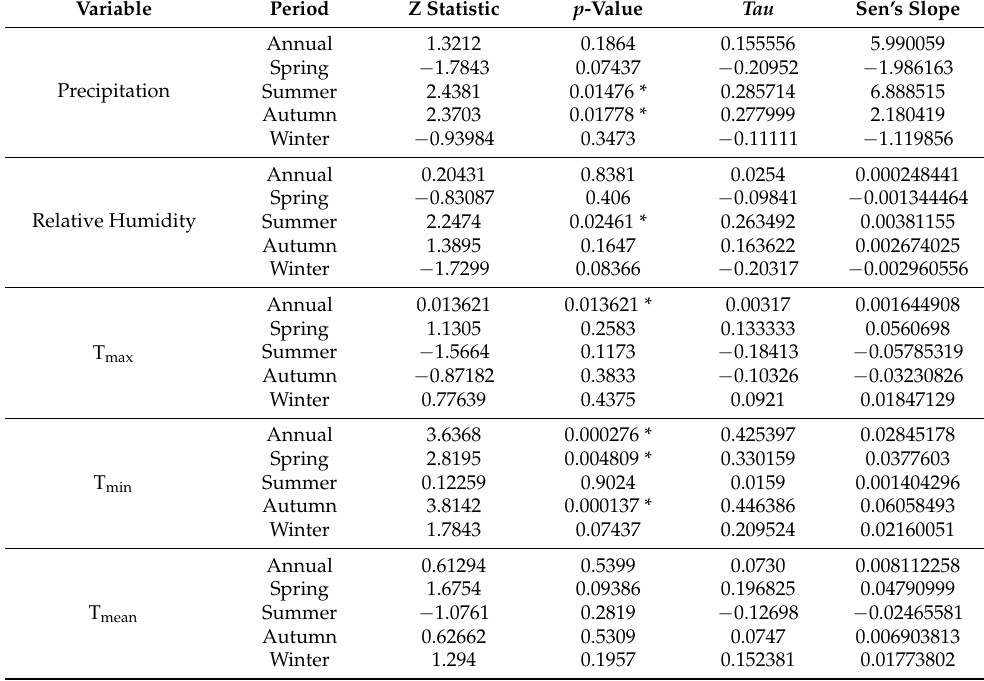
Table 7. MK test results for MB Din for the period 1979–2014.